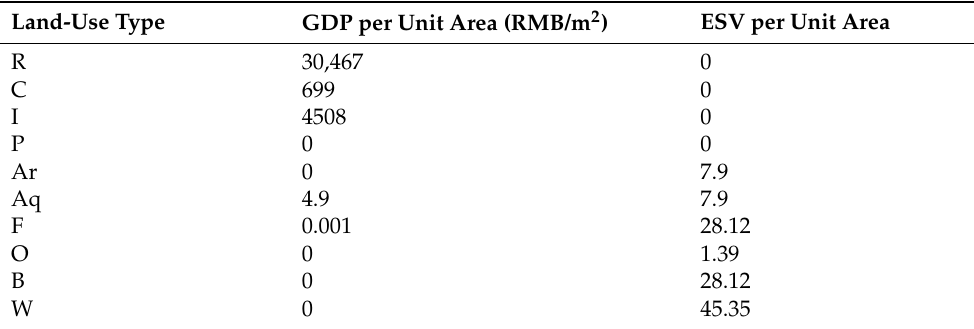
Table 2. GDP (Gross Domestic Product) and ESV (Ecological Service Value) per unit area for different land-use types. Land-use type abbreviations are as per Table 1. Land-Use Type GDP per Unit Area (RMB/m 2